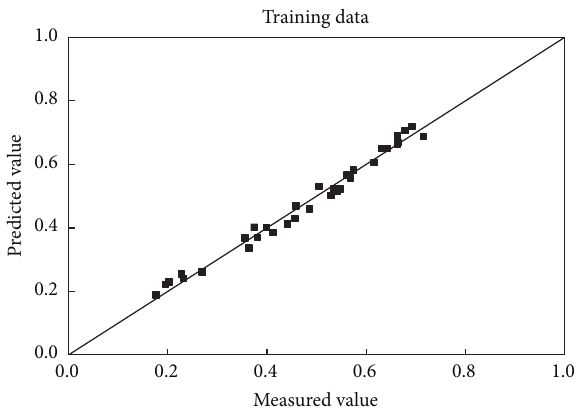
Figure 6: Comparison of the predicted and measured wall factors of rectangular prisms for the training data.